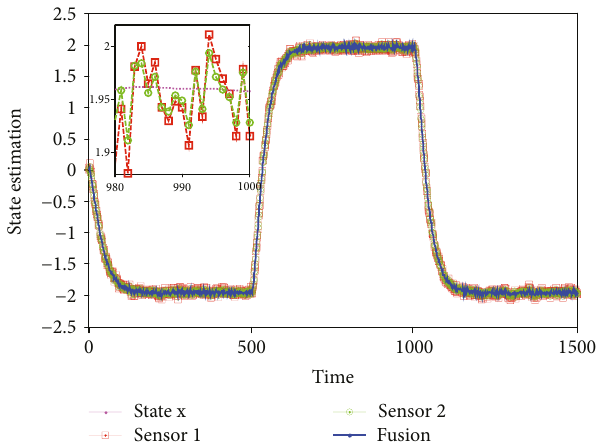
Figure 13: The estimate error of x and fusion) ( L